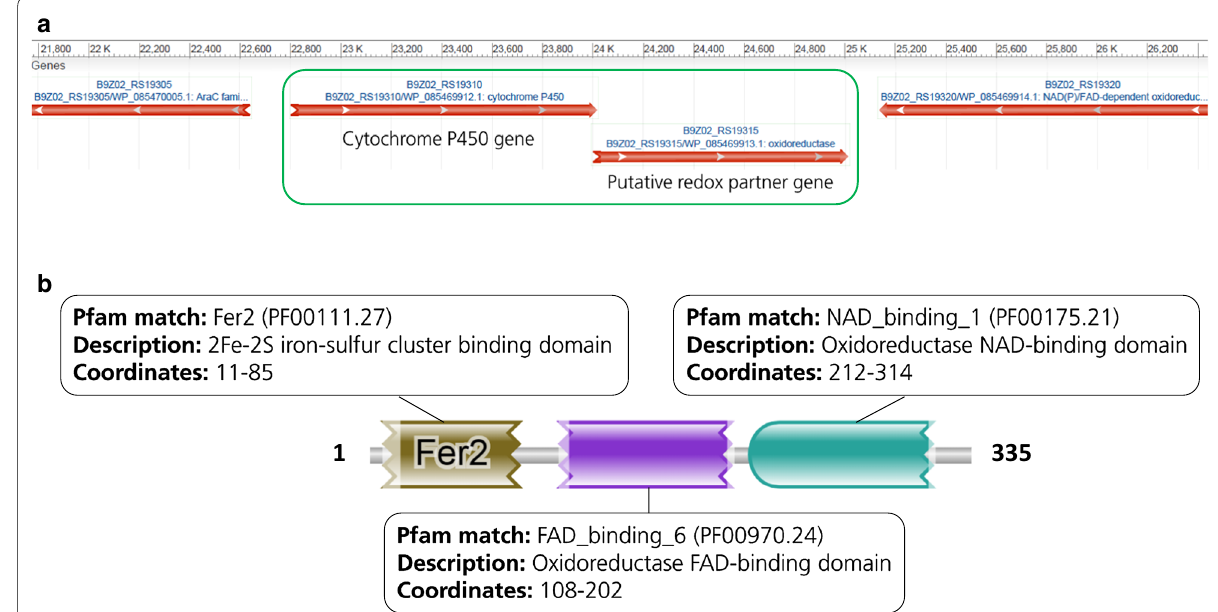
Fig. 3 a Detail of the local genomic context of the CYP gene in Rhodococcus rhodochrous J3 and its companion gene encoding a redox partner protein. b Results of HMMER analysis of the amino acid sequence of the redox partner from Rhodococcus rhodochrous J3 (WP_085469913.1), showing three predicted